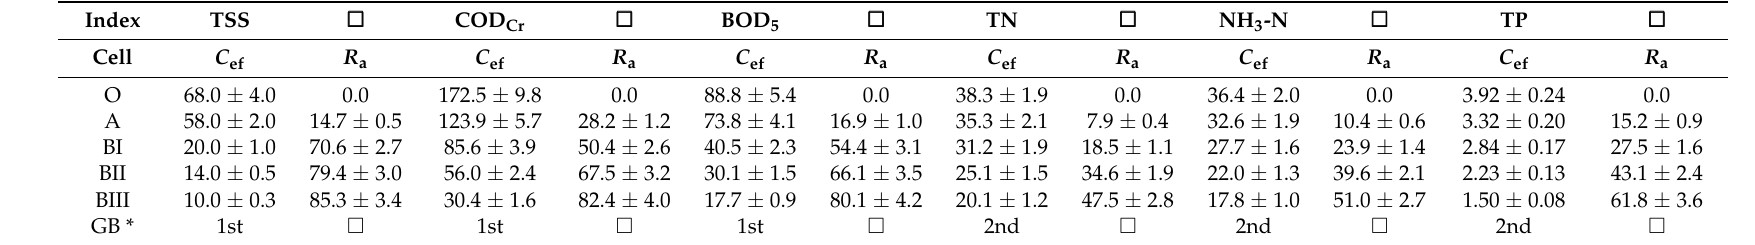
Table 3. Annual average effluent concentration C ef (mg/L) and accumulative removal rate R a